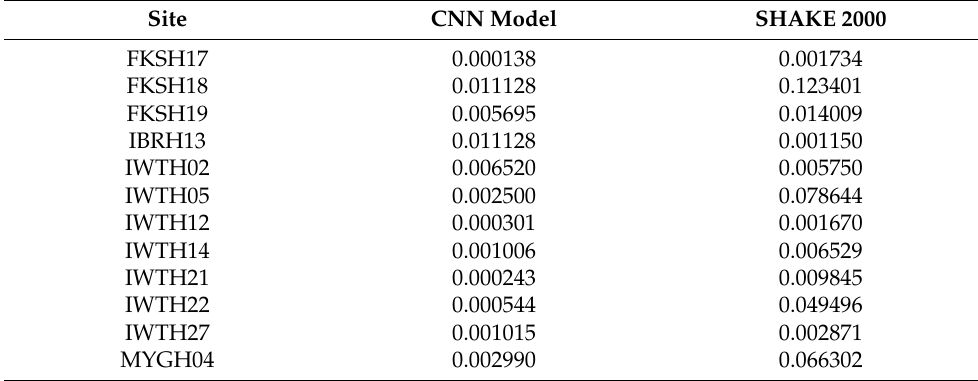
Table 3. Average mean squared error of the proposed model and